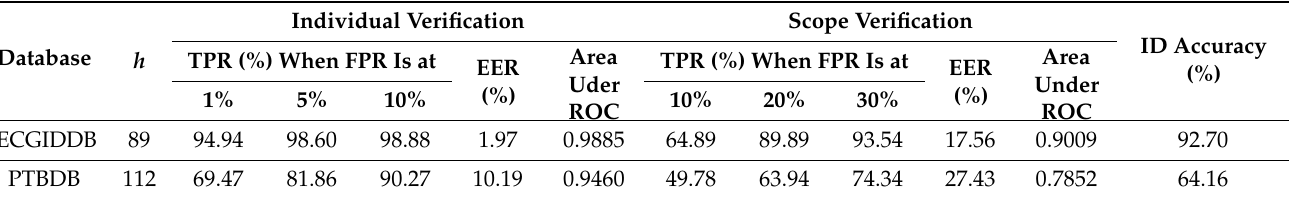
Table 11. Performance over long time